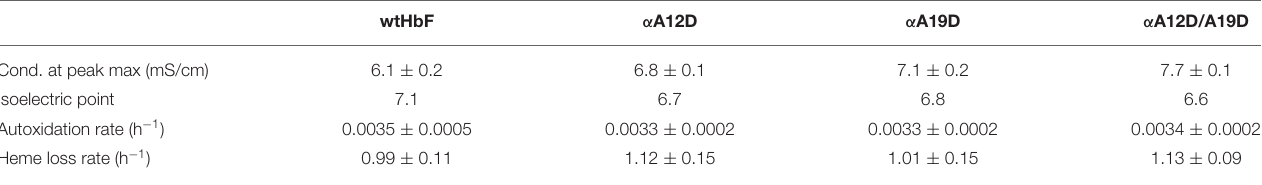
TABLE 1 | Anion chromatography elution data, pI determination ( n ≥ 2), autoxidation rates, and heme loss rates of wtHbF, α A12D, α A19D, and α A12D/A19D (IEF gel picture can be found in the Supplementary Figure 2 ). wtHbF α A12D α A19D α A12D/A19D Cond. at peak max